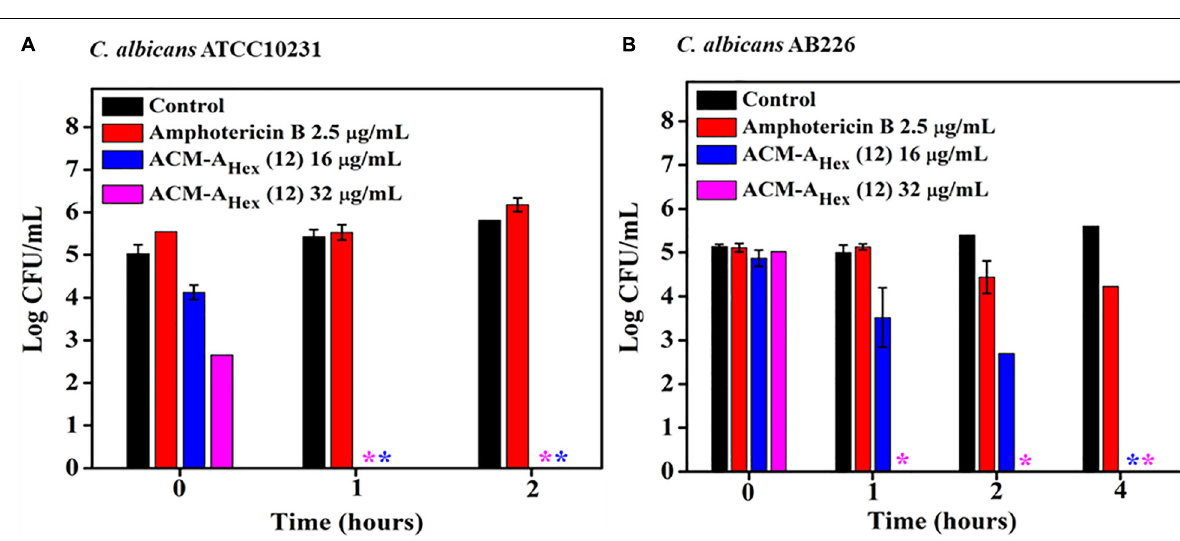
FIGURE 4 | Time kill kinetics of ACM-A Hex ( 12 ) against (A) C. albicans ATCC10231 and (B) C. albicans AB226. (Asterisks corresponds to < 50 CFU/mL). Each point represents average of four different values and error bar indicates standard deviation ( p < 0.0001, two-way